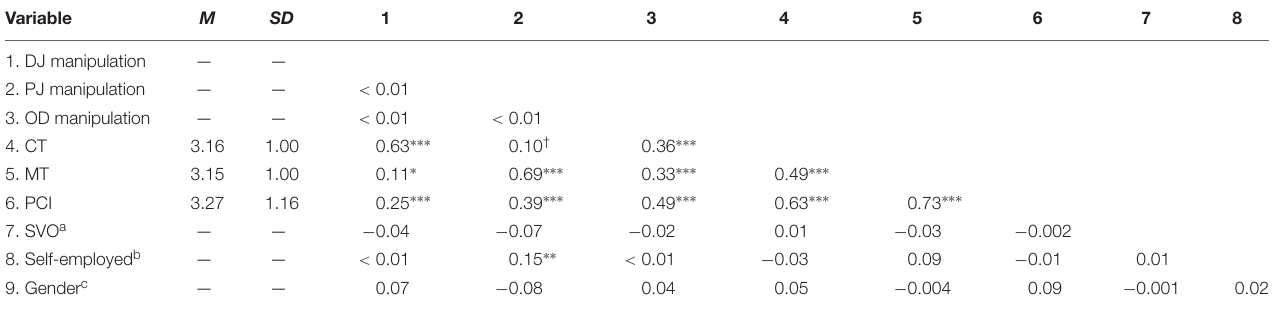
TABLE 1 | Summary statistics and intercorrelations (Study 1). Variable